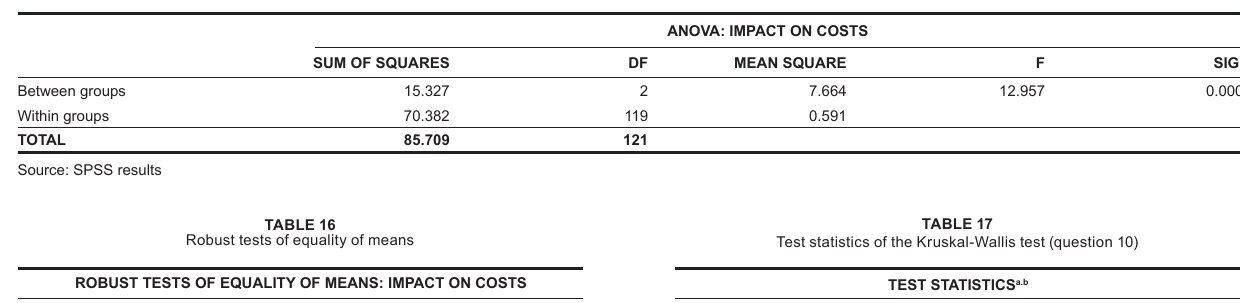
TABLE 15 ANOVA results (question 10)